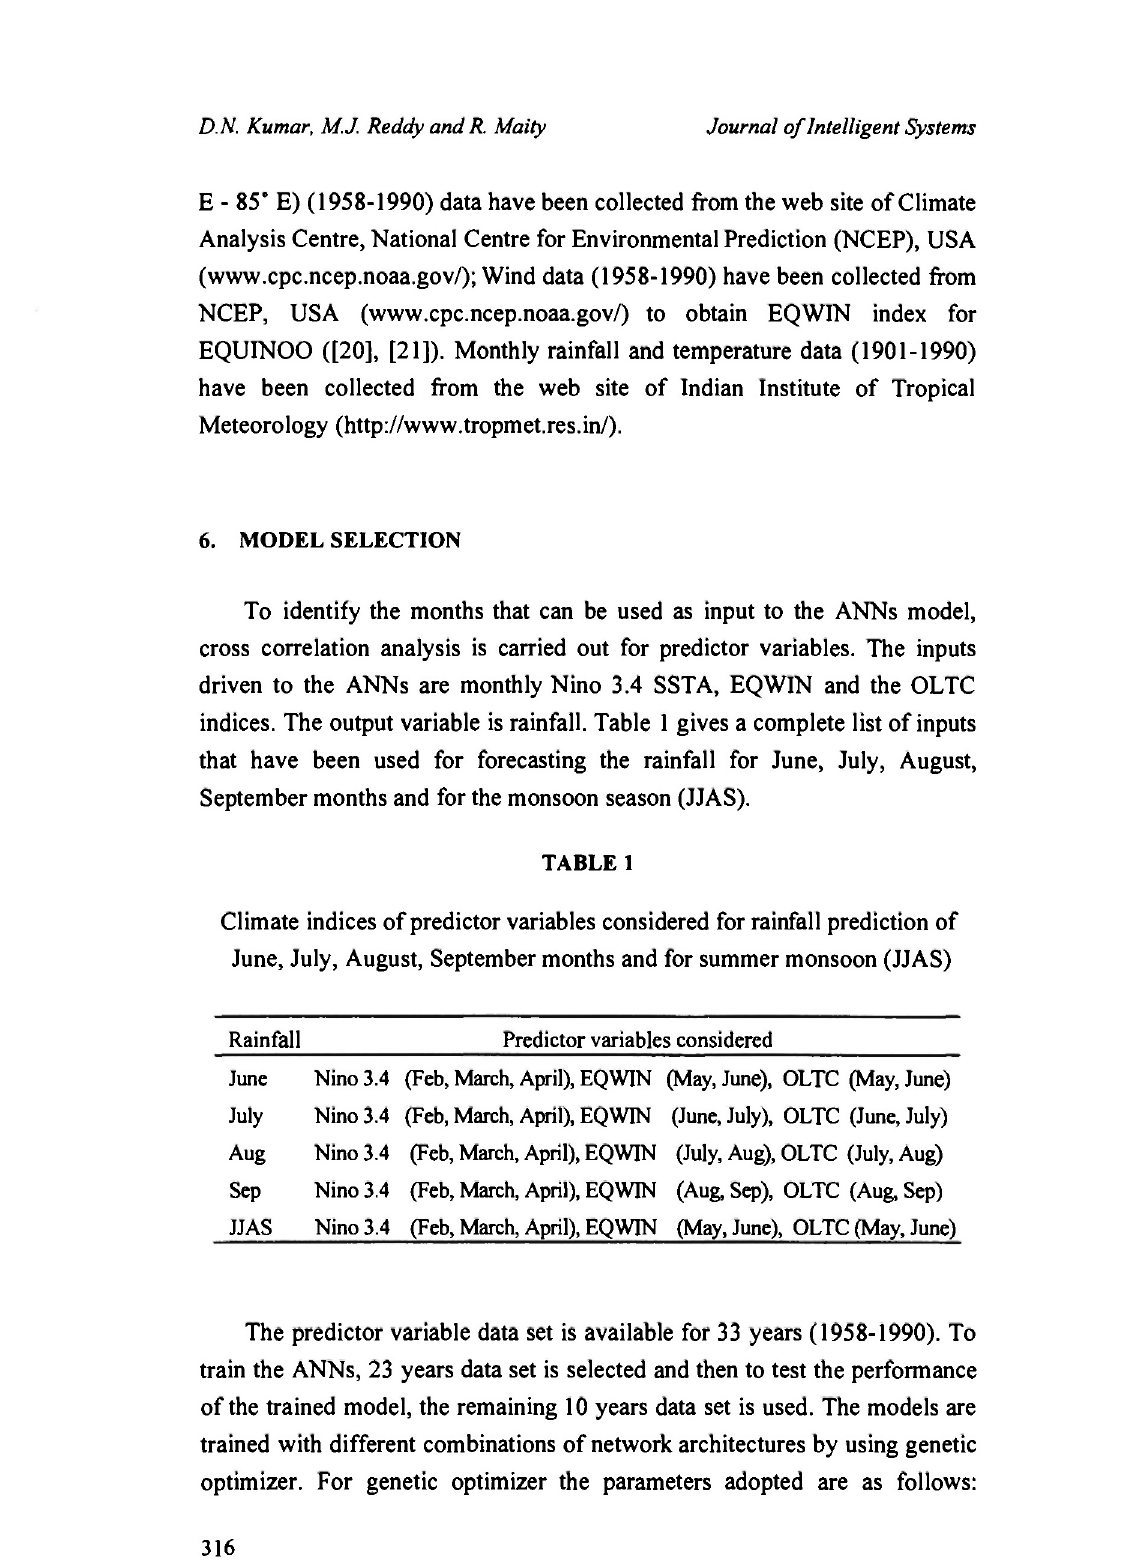
Rainfall Predictor variables